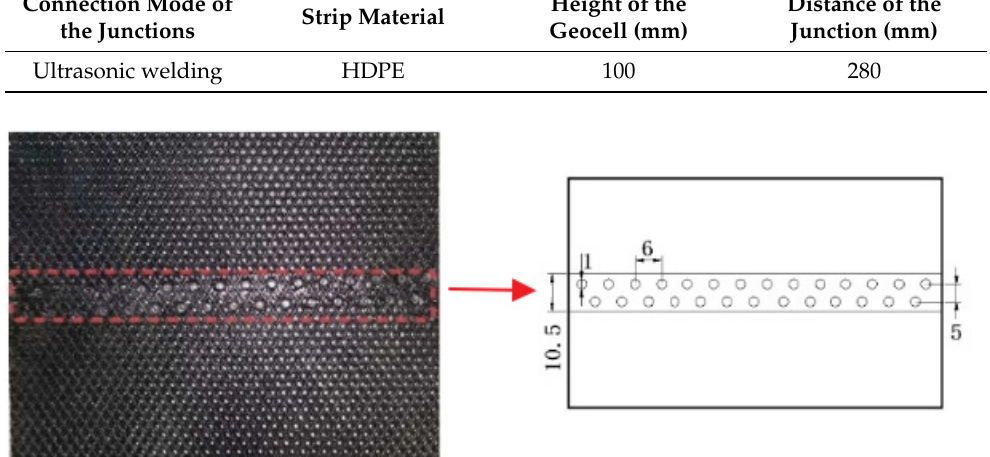
Figure 3. Details of the geocell junction. (unit: mm).